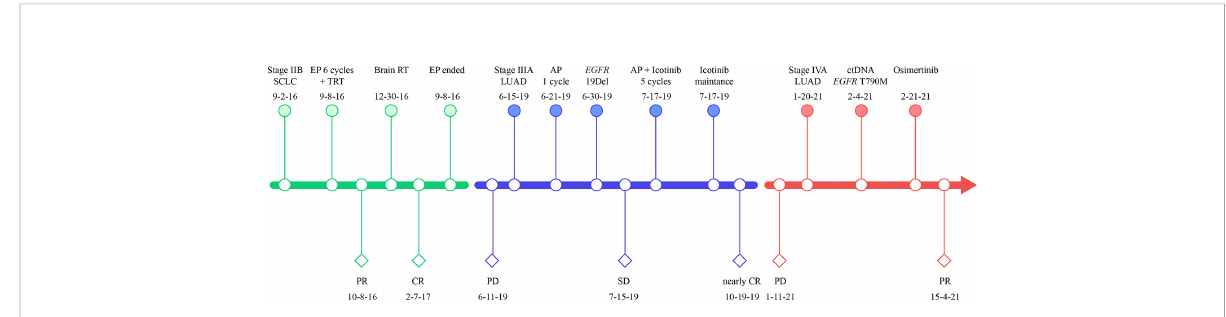
FIGURE 3 Treatment timeline of our case. SCLC, small-cell lung cancer; LUAD, lung adenocarcinoma; EP, etoposide plus cisplatin; TRT, thoracic radiation therapy; RT, radiation therapy; AP, cisplatin plus pemetrexed; PR, partial response; CR, complete response, PD, progressive disease; EGFR, epidermal growth factor receptor; 19Del, exon 19